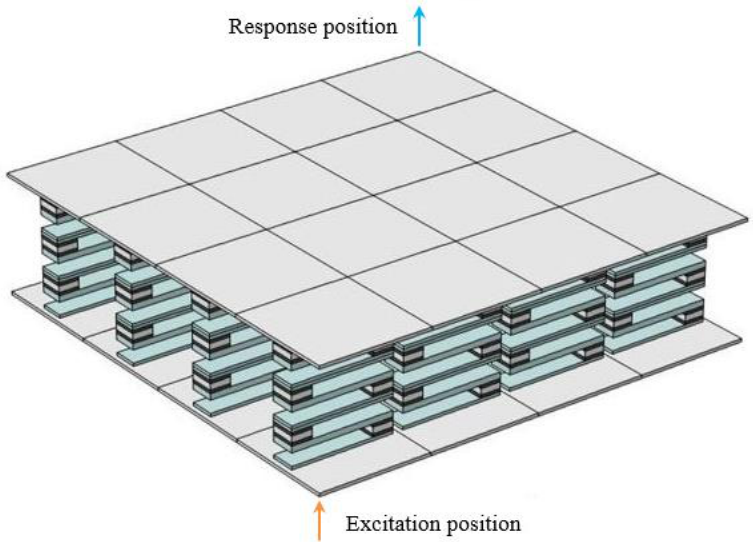
Figure 6. Structure model of phononic crystal sandwich plate composed of 16 cells arranged periodically.